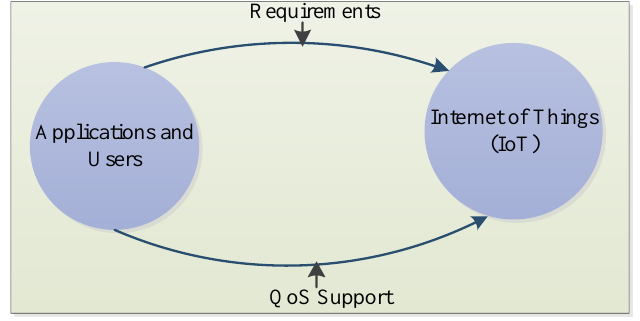
Figure 24. QoS support for IoT.